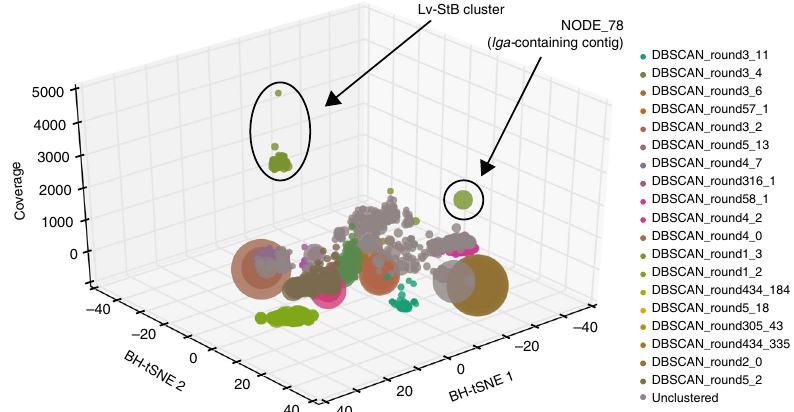
Fig. 5 The gene cluster putatively involved in lagriamide biosynthesis is present on a genomic island within the Burkholderia gladioli Lv-StB genome. 3D scatter plot of de novo shotgun assembly for bacterial contigs greater than 10 kbp from a Lagria villosa egg metagenome. Each point represents a contig in the metagenomic assembly and is scaled by length and colored by its corresponding Autometa cluster. The gray points represent contigs that remained unclustered by